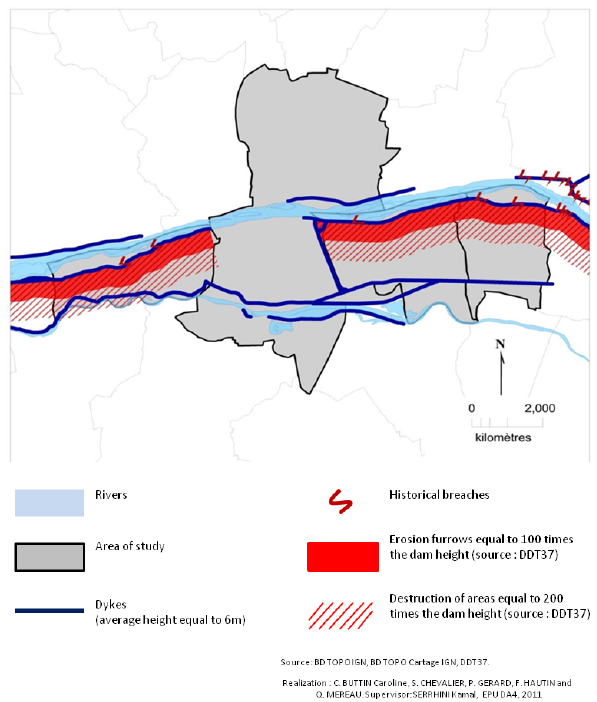
Figure 6. Break levees and potential damage on the Tours